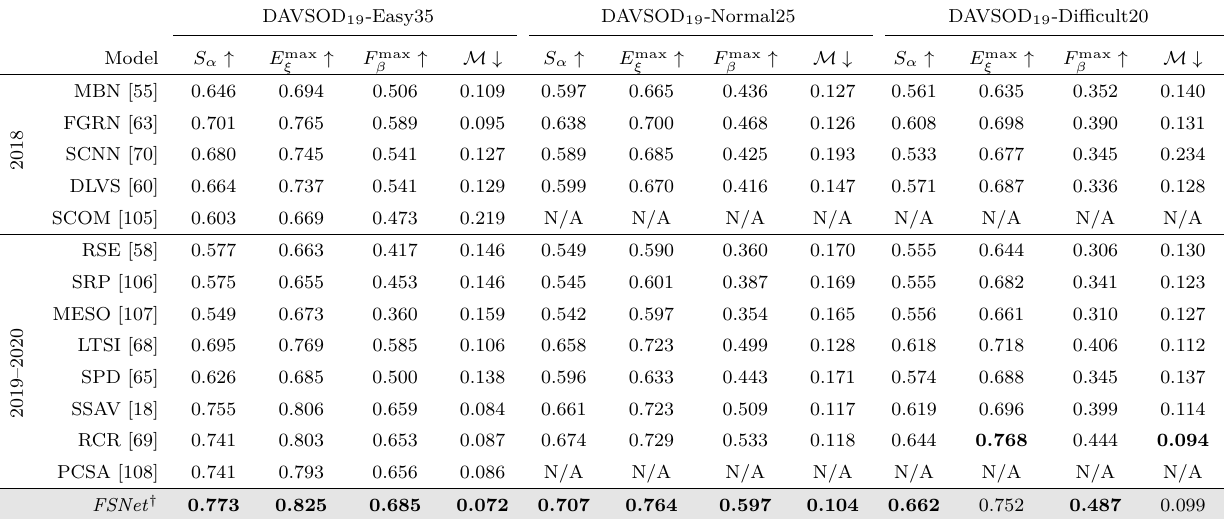
Table 3 Benchmarking results of 13 state-of-the-art V-SOD models on three subsets of DAVSOD 19 [18]. † denotes that we generate non-binary saliency maps without CRF [84] to enable a fair comparison. N/A means results are not available DAVSOD 19 -Easy35 DAVSOD 19 -Normal25 DAVSOD 19 -Difficult20